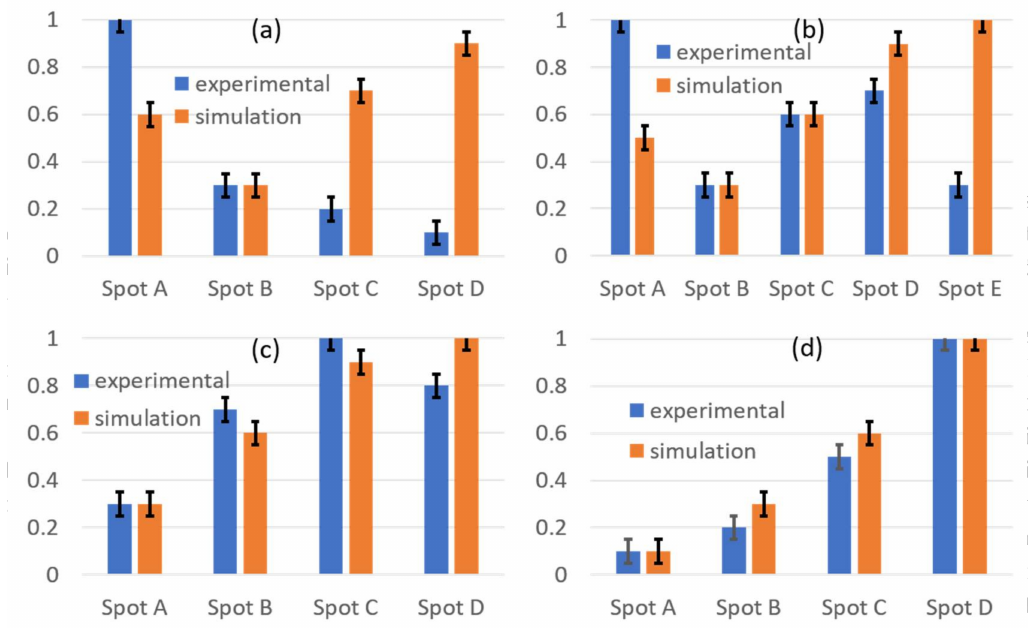
Figure 10. Spectral-angular data conversion for TM of each prominent “spot” to 1D column graph. The labels A, B, C, D, and E refer to the spots from left to right in Figure 8 in each intensity map, while panels a-d correspond to different incident angles 30 ◦ ( a ), 40 ◦ ( b ), 50 ◦ ( c ), and 60 ◦ ( d ). Error bars reflect a 10% uncertainty. All intensities are on a relative zero to one scaling